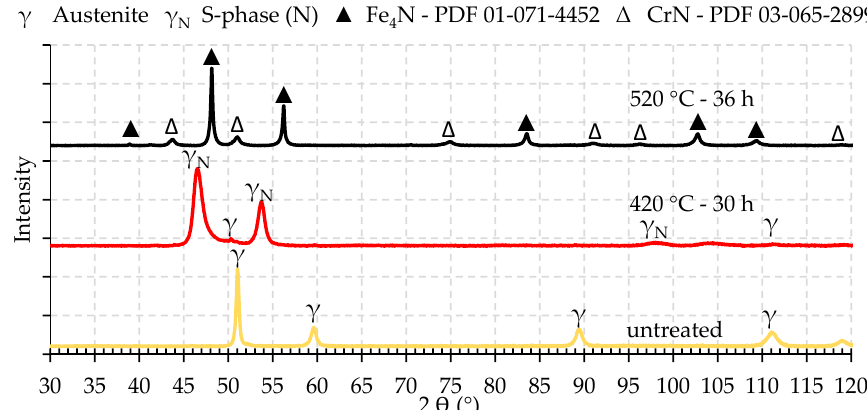
Figure 4. Diffraction diagrams of the gas nitrided and untreated AISI 316L HVOF coating in as-sprayed condition.